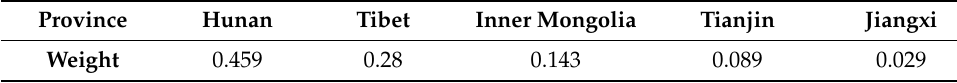
Table 1. Weight components of Chongqing.